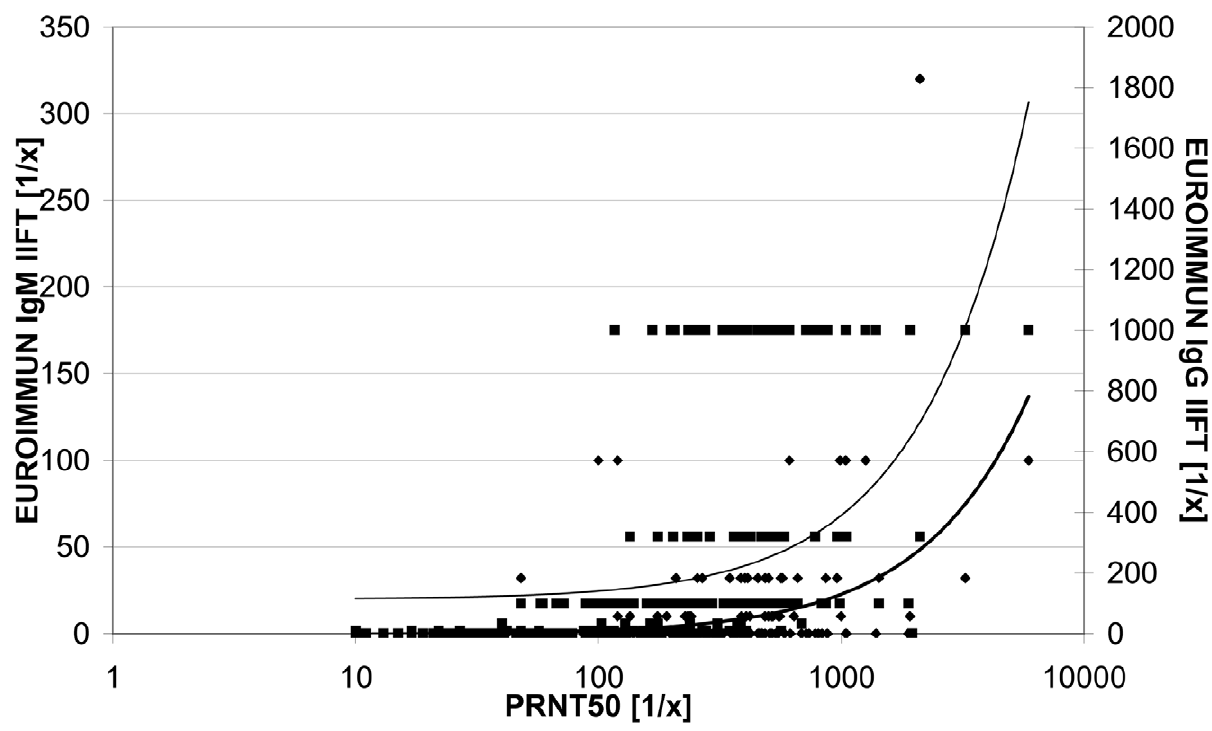
Figure 3. Scatter blot comparing the results of the PRNT50 with the results of the EUROIMMUN IIFT. Test values: IgM ( X ), IgG ( & ). Trend line: IgM (thick), IgG (thin).